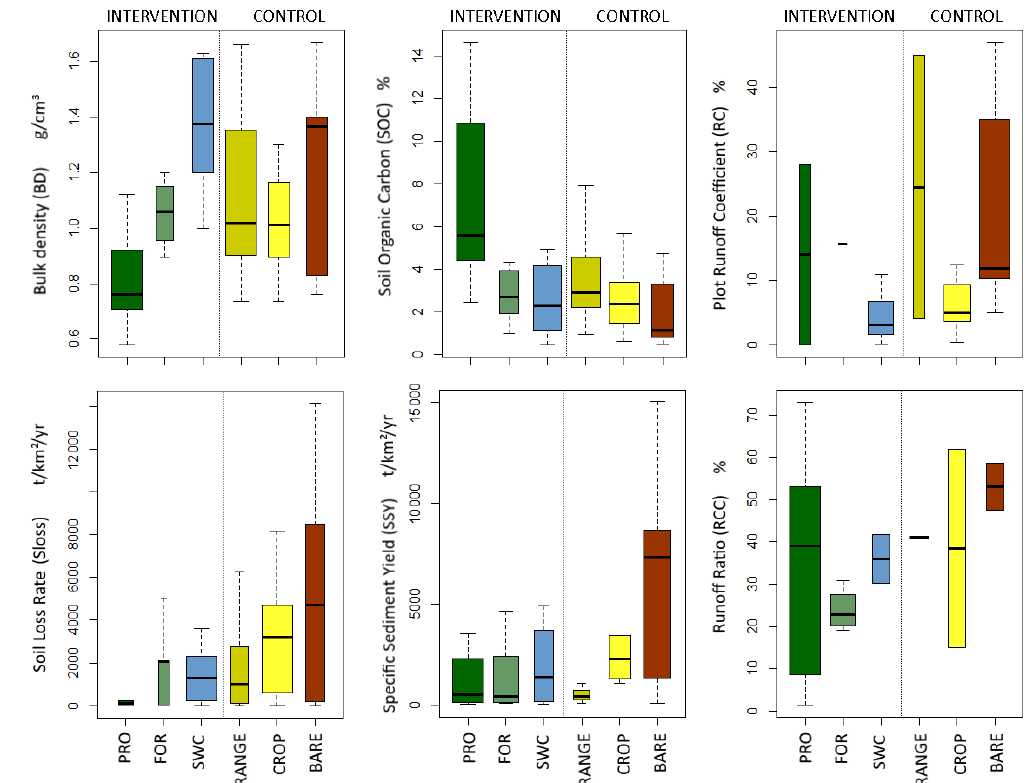
Figure 4. Variation in bulk density, soil organic carbon content, runoff coefficient, soil loss rate, specific sediment yield and catchment runoff coefficient between the three categories of natural infrastructure intervention (PRO, FOR, SWC), the untreated agricultural (RANGE, CROP) and bare land (BARE). Bold lines represent the median values, boxes extend to first and third quantiles and whiskers to 1.5 times the interquartile range from the